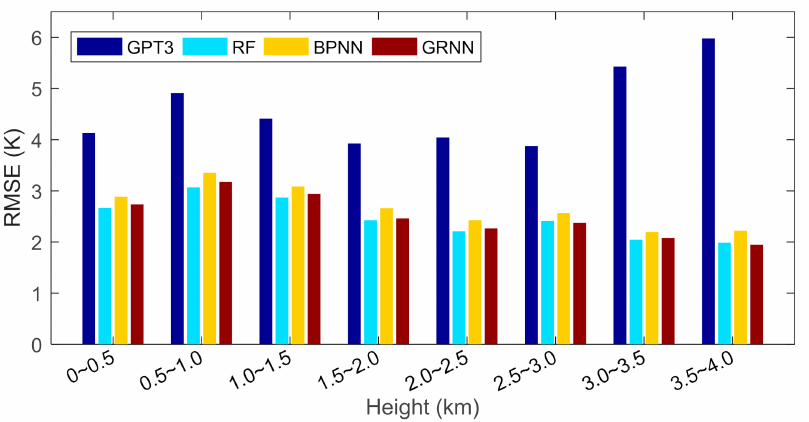
Figure 9. Root mean square errors of different models at different height